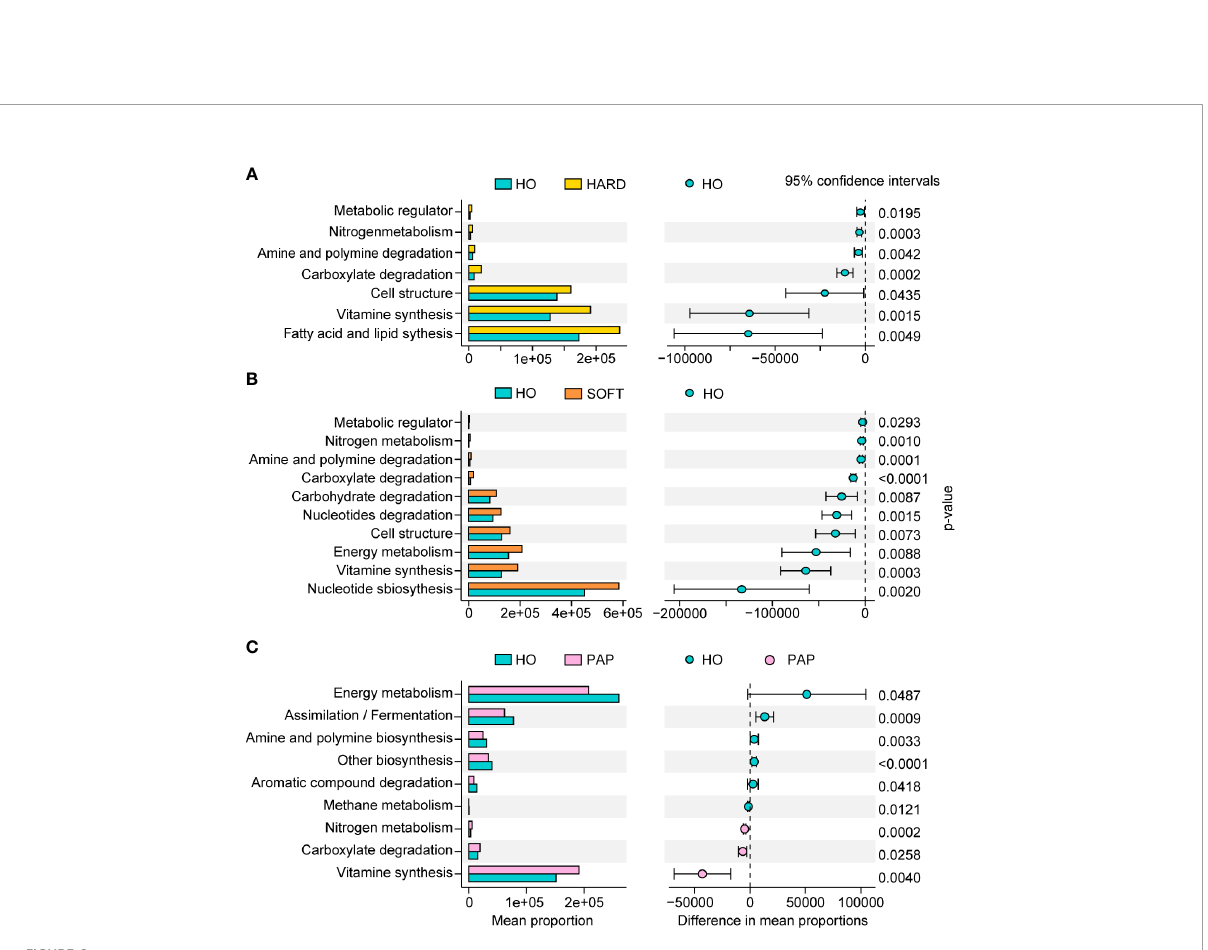
FIGURE 6 Metabolic pathway differences in microbiota in HARD (A) , SOFT (B) and PAP (C) samples compared with HO. The p values at the 95% con fi dence intervals indicated the potential activity differences of the metabolic